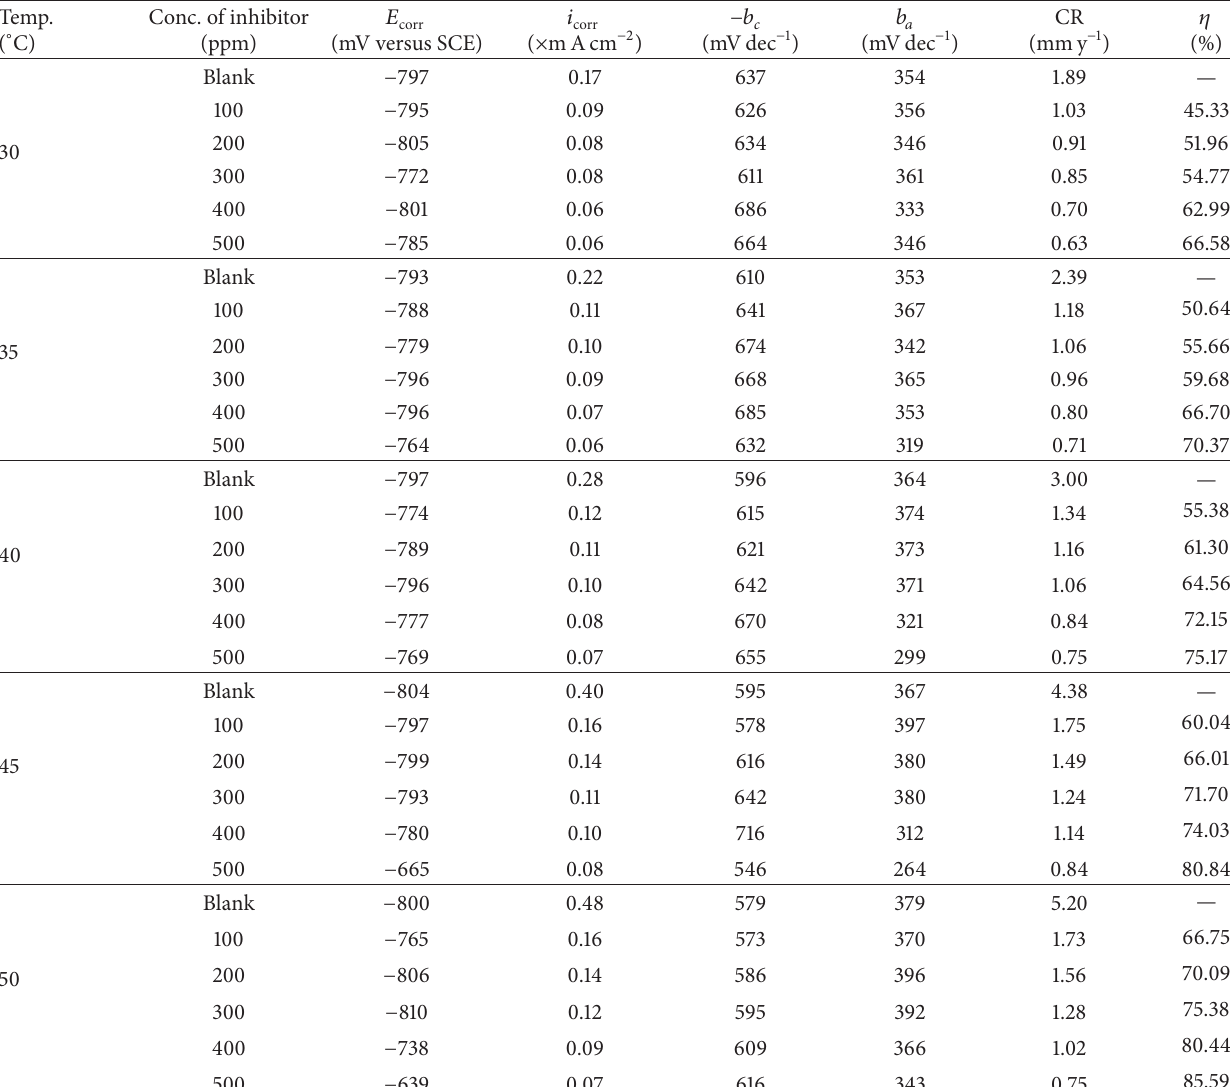
Table 1: Results of Tafel polarization studies on aluminum in 0.5 M phosphoric acid solution containing different concentrations of inhibitor GIE.